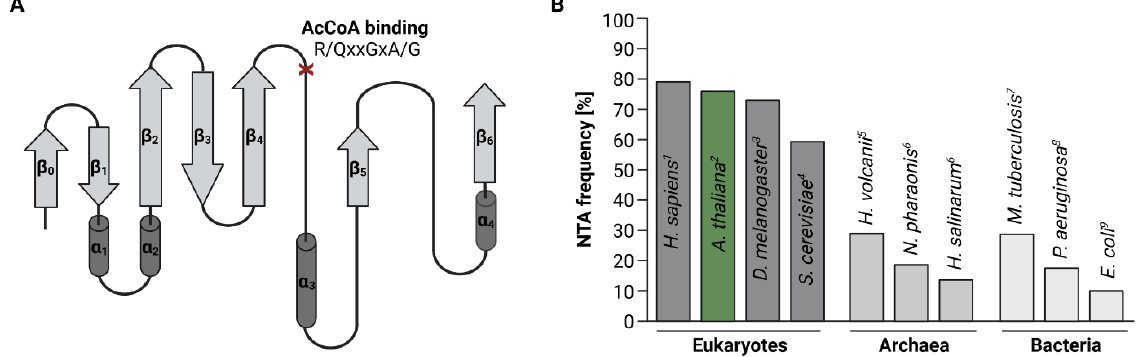
Figure 1. The typical GNAT fold is conserved throughout all domains of life. ( A ) The core GNAT fold consists of six to seven β -strands ( β 0 – β 6, light grey) and four α -helices ( α 1 – α 4 , dark grey). The loop connecting β 4 and α 3 contains a conserved AcCoA binding motif (R/QxxGxA/G, red cross). Differences between GNAT structures are generally confined to the N-terminal β 0 strand. ( B ) NTA frequency in different organisms as a percentage of the whole proteome. The bars represent the estimated upper limit reported for the individual organisms ( 1 : [23], 2 : [20], 3 : [24], 4 : [25], 5 : [26], 6 : [27], 7 : [28], 8 : [29] and 9 : [30]).